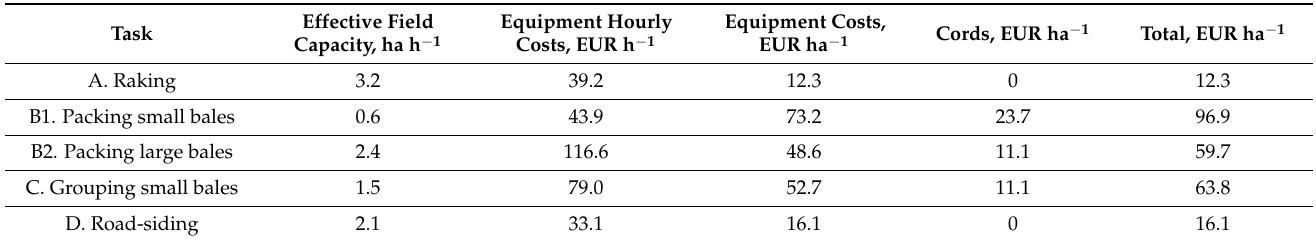
Table 5. Effective field capacity of each operation.